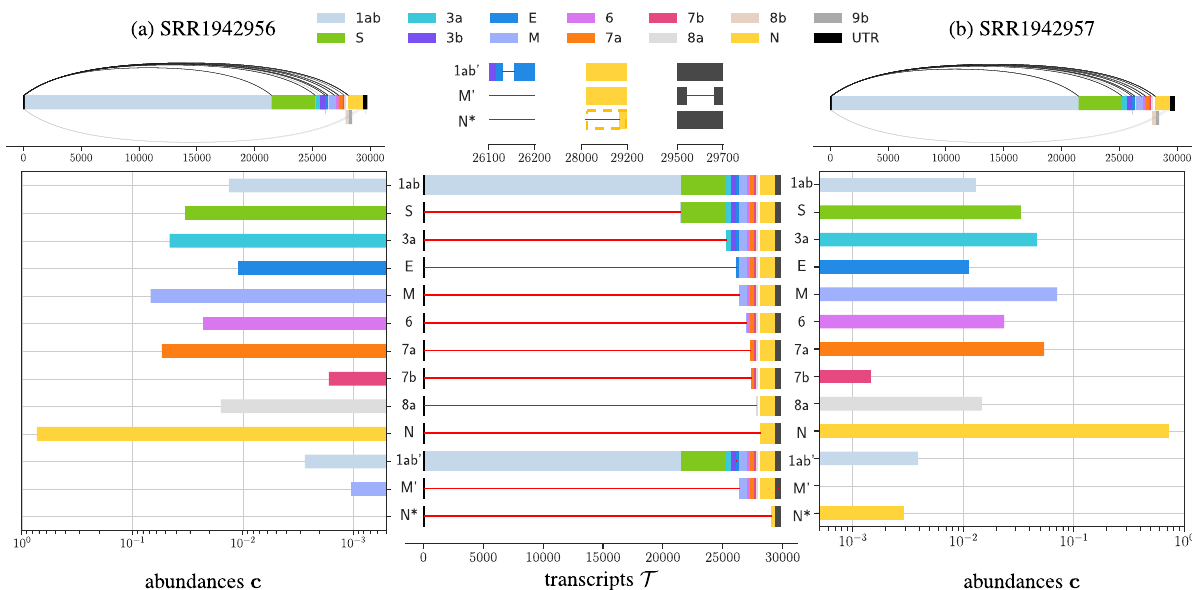
Fig. 6 JUMPER identi fi es canonical and non-canonical transcripts that recur in two short-read sequencing samples of SARS-CoV-1-infected Calu-3 cells 24 . For both the samples, a SRR1942956 and b SRR1942957, we show the segment graph, with canonical (above) and non-canonical (below) discontinuous edges. We also show the predicted transcripts and their abundances in the two samples with a zoomed-in view of the non-canonical transcripts 1ab', M' and N*. UTR: untranslated